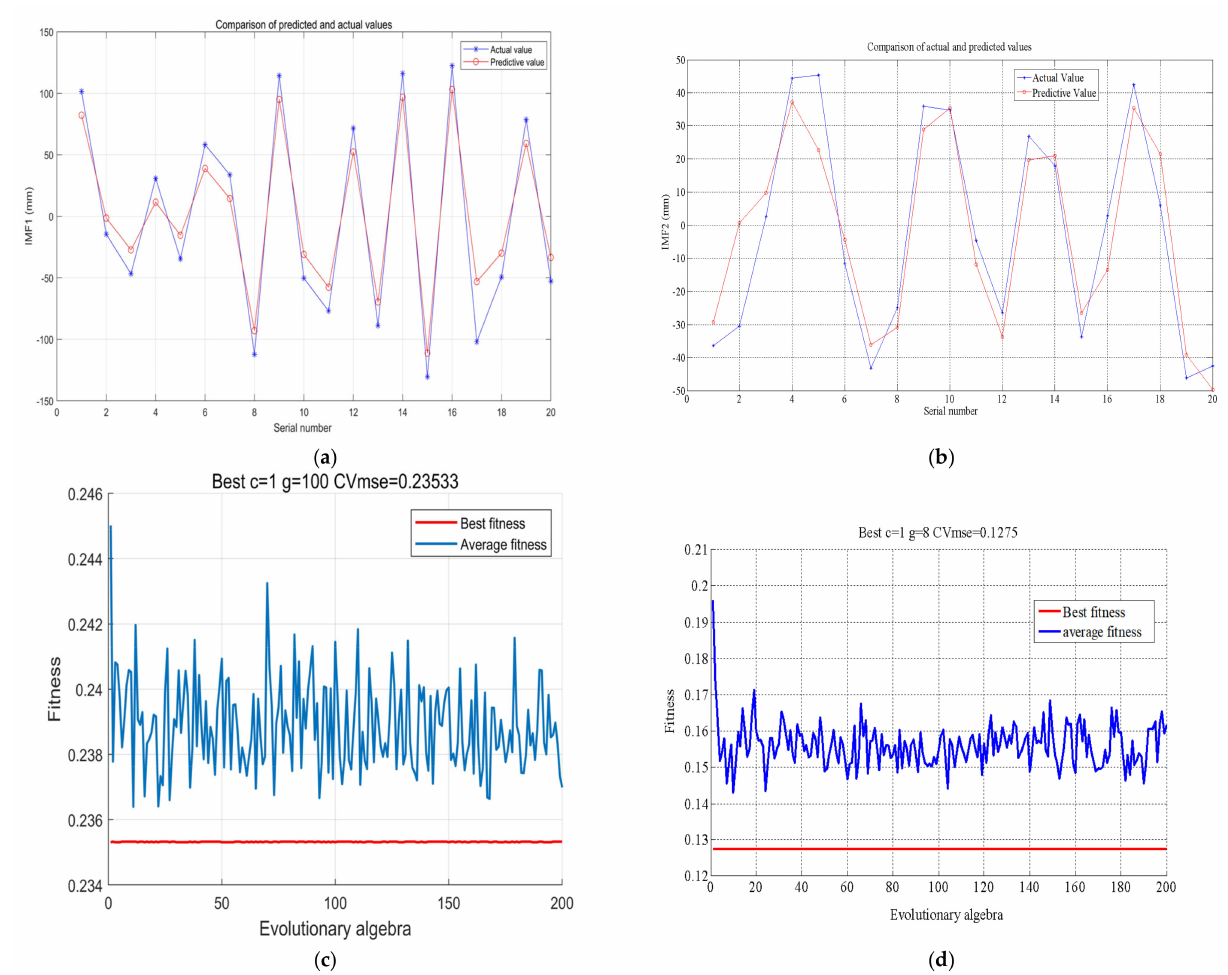
Figure 5. Comparison of predicted and actual values of IMF1 − IMF2. ( a ) IMF1 predicted versus true values; ( b ) IMF2 predicted versus true values; ( c ) IMF1 fitness value; ( d ) IMF2 adaptation